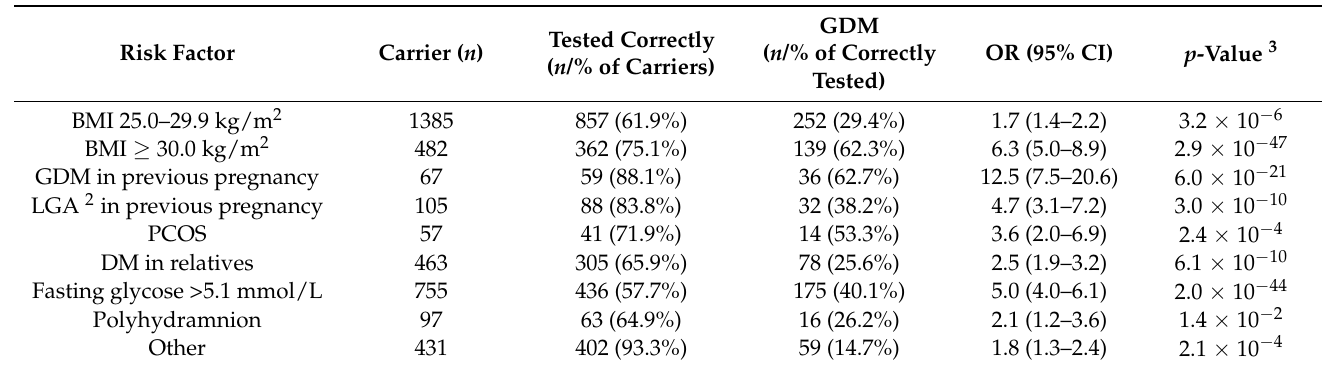
Table 2. Adherence to GDM screening algorithm 1 among high-risk women and odds to receive GDM diagnosis.